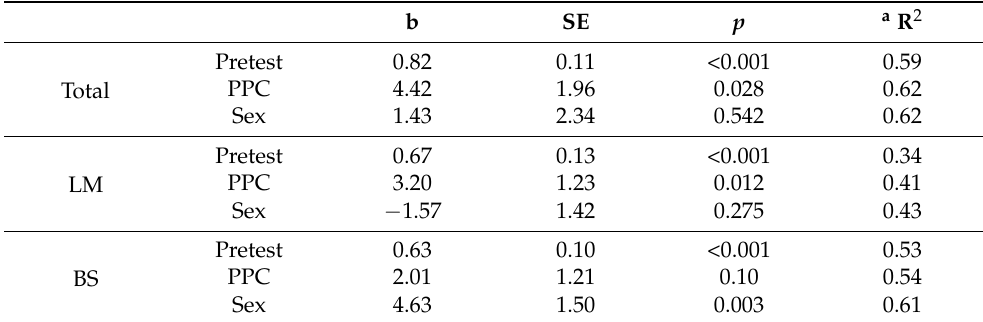
Table 2. Linear regression models predicting posttest motor